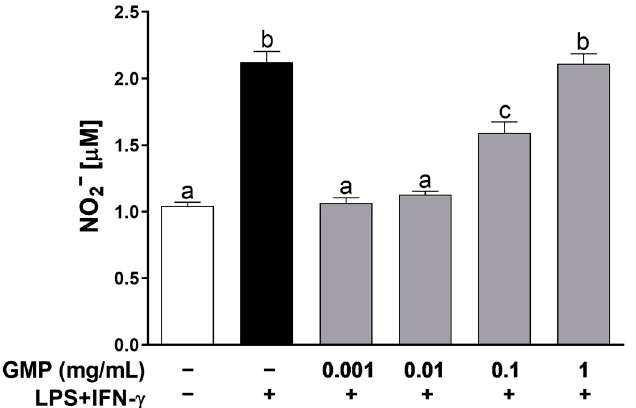
Figure 1. E ff ect of GMP on NO production by stimulated U937 macrophages. Cells were incubated in the absence or presence of increasing concentrations of GMP for 12 h and later stimulated with LPS (10 µg/mL) and IFN- γ (20 ng/mL) for 24 h ( n = 9, 3 independent experiments in triplicate). Means followed by different letters (a, b, c) are significantly different.